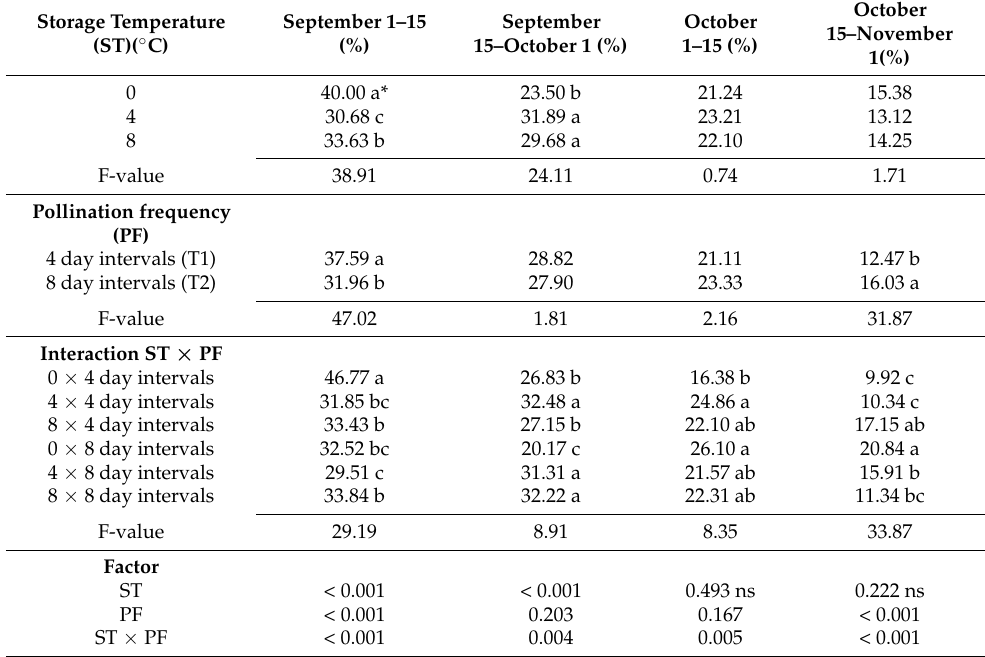
Table 3. Effects of storage temperature, pollination frequency and the interaction of storage tempera- ture × pollination frequency on time of ripening of fruits.